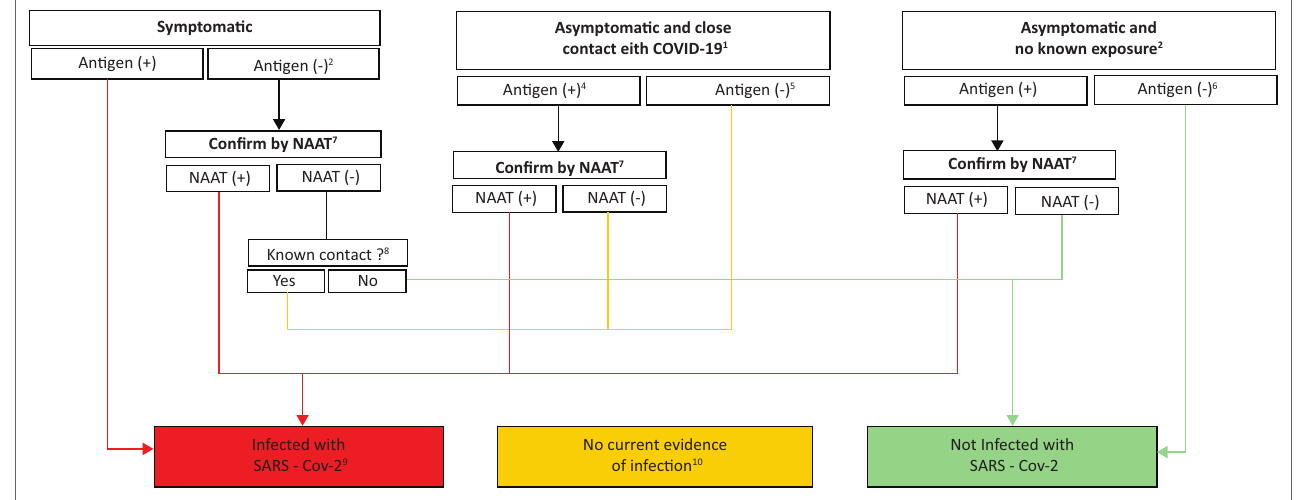
FIGURE 6: Standard operational procedure for the assignment of Muhammadiyah volunteers during the COVID-19 pandemic.